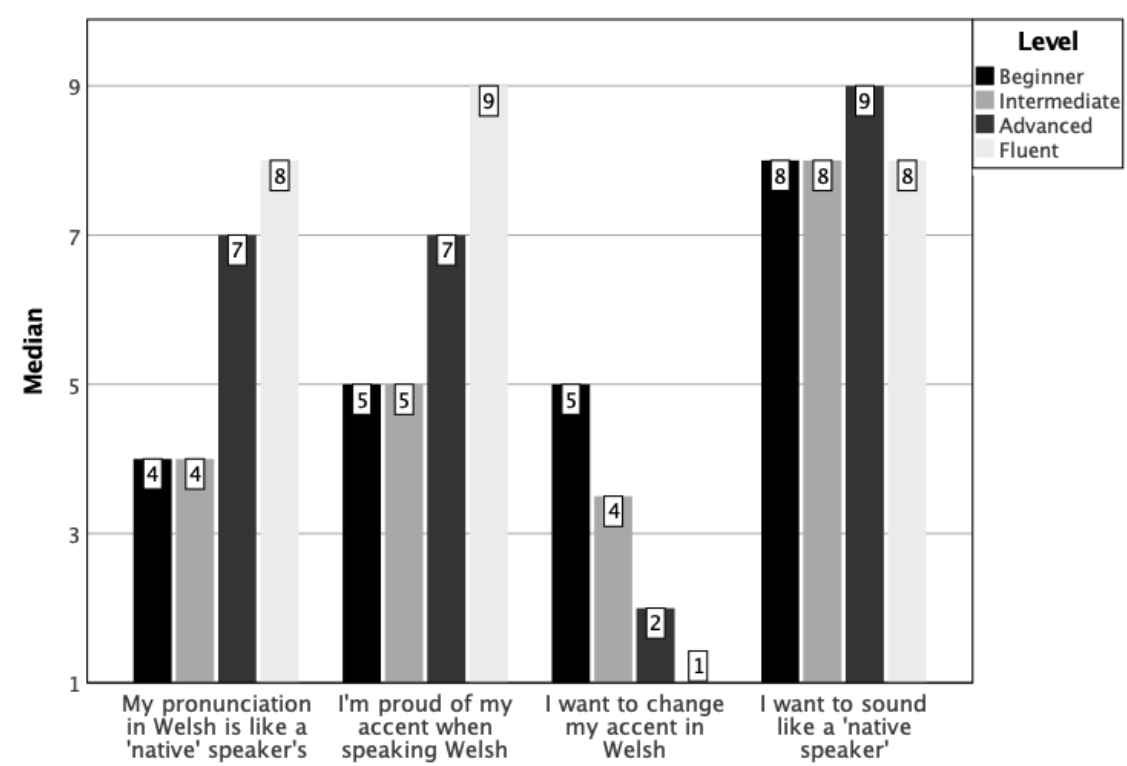
Figure 3. Median scores for statements on accent and pronunciation for the four levels (1 = Not at all, 9 = Completely).